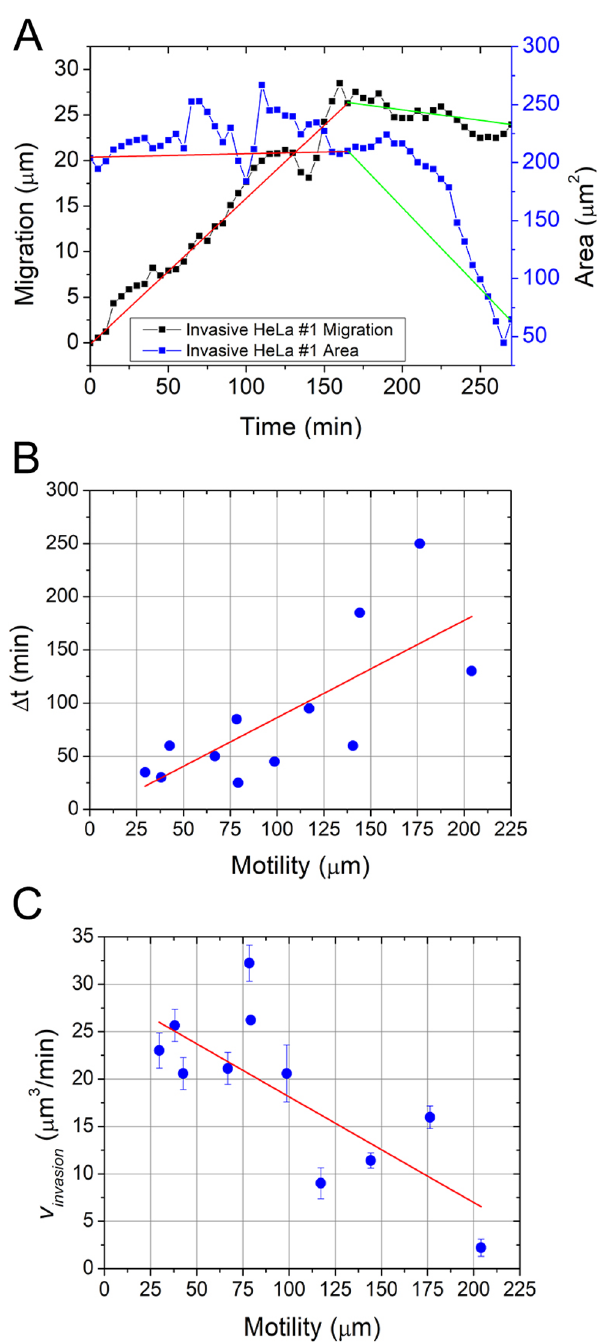
r = 0.743. ( C ) Derivate slope v invasion correlates ( r = -0.768) with